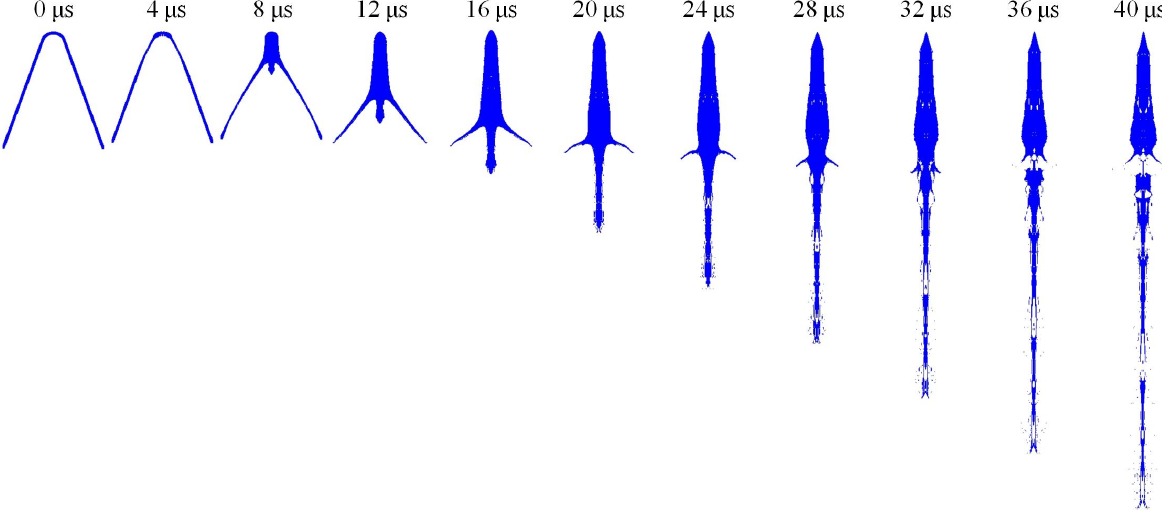
Figure 2. Shape variations of the jet from the conical liner with time.